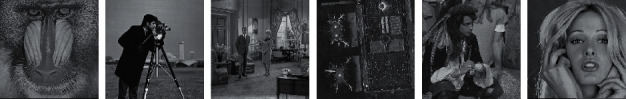
Original gray images.